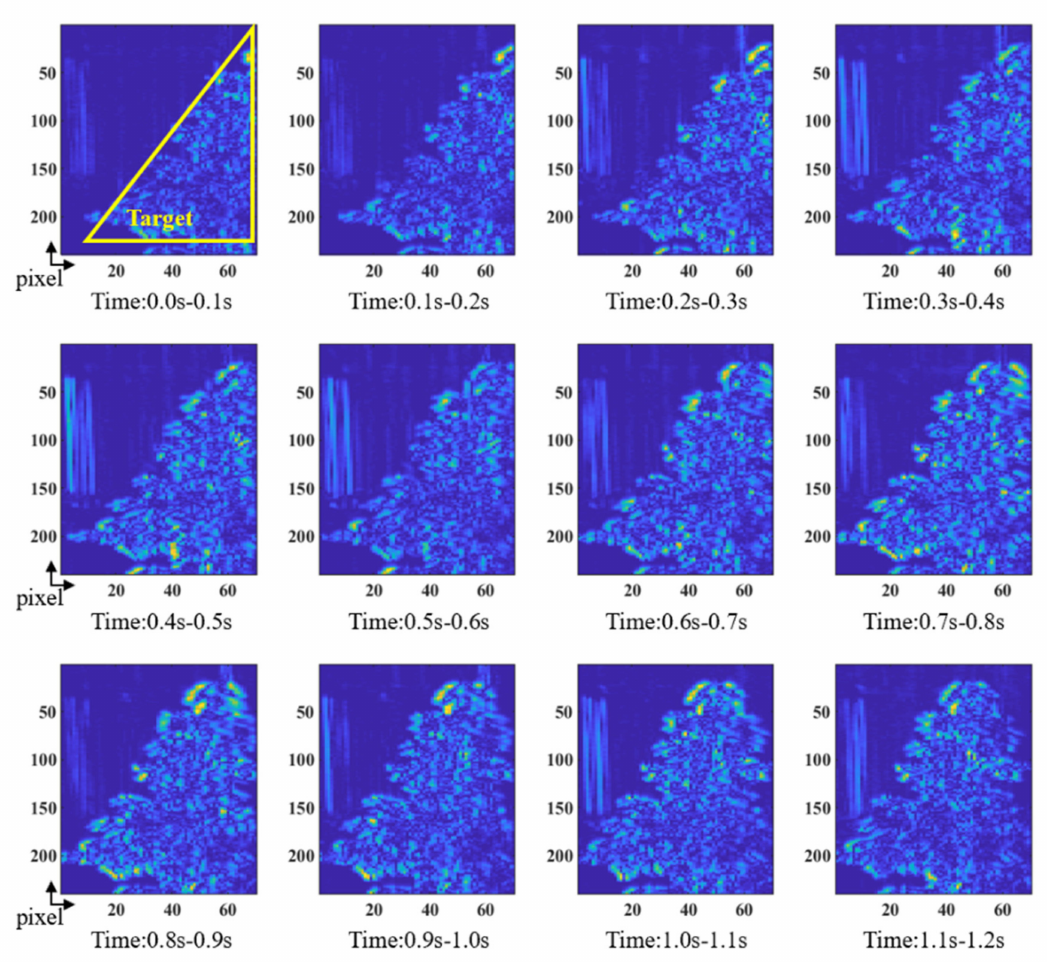
Figure 10. The optical flow method identifies the motion information between adjacent frames with a time difference of 0.1